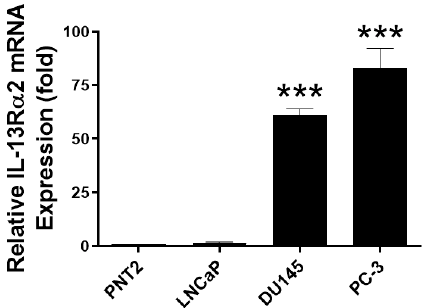
Figure 7. Expression of IL-13R α 2 mRNA in prostate cell lines in 3-dimensional culture. mRNA was isolated from the cells grown in a Terasaki plate to generate a spheroid and RT-PCR was used to quantify mRNA expression using IL-13R α 2 specific primers. The data represent means ± SEM (error bars represent SEM) of three independent experiments. All RT-PCR results were normalised to housekeeping controls. IL-13R α 2 levels in cancerous LNCaP, DU145 and PC-3 cells were compared to those in non-cancerous PNT2 cells (*** p < 0.001).